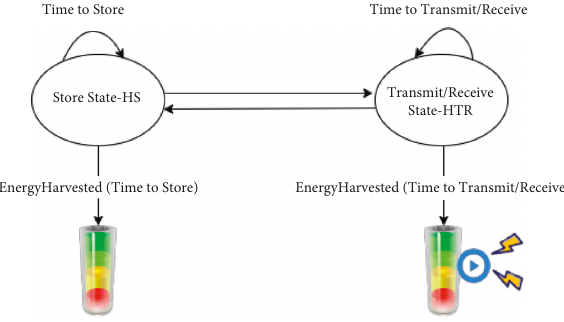
Figure 5: Two states model of EHNT.